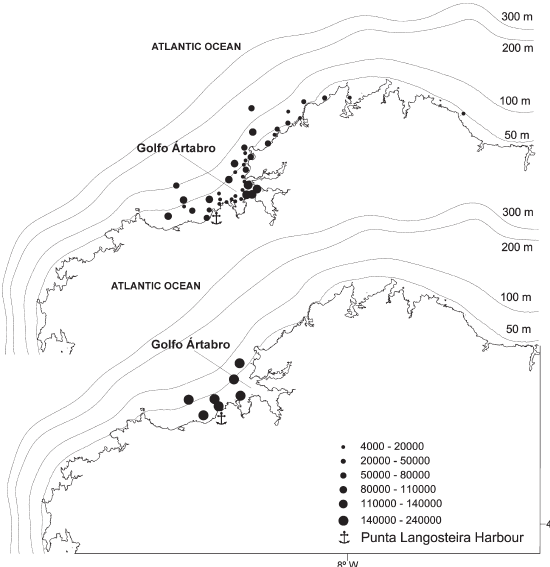
Fig . 5. – Fishing grounds and total revenue (in €) derived from their commercial exploitation in 2004 by the purse seine fleet with base ports in the north (top) and south